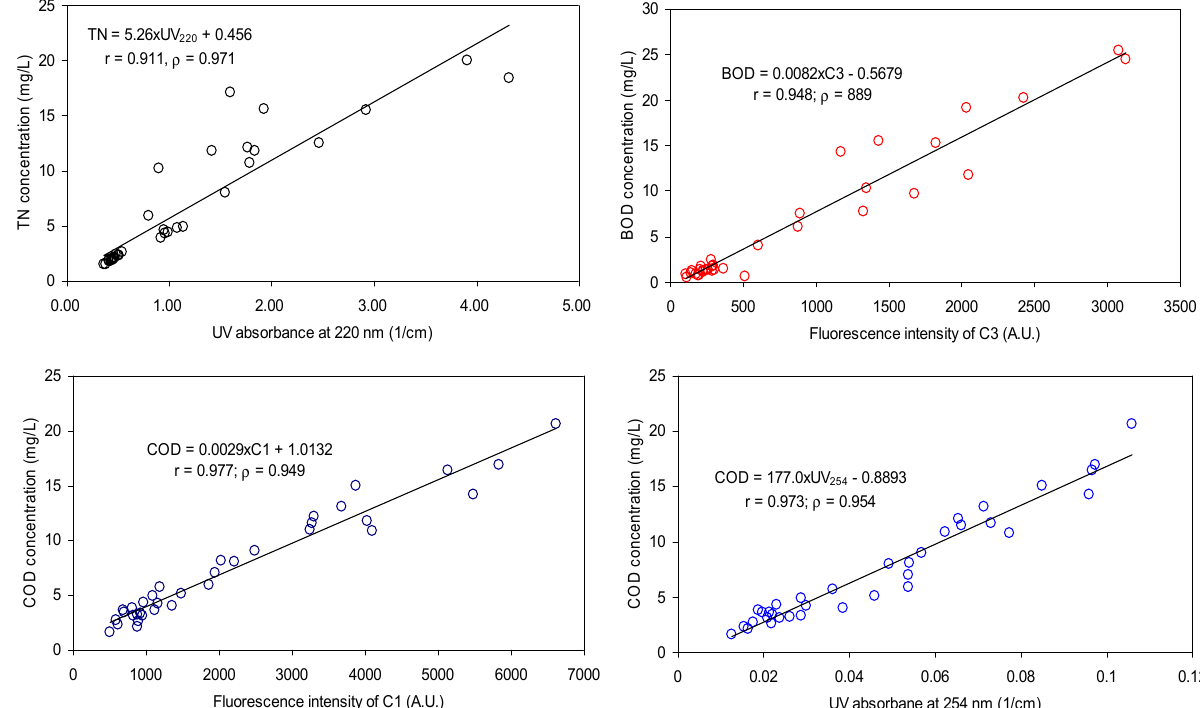
Figure 5. Correlations between selected spectroscopic indices (UV absorption indices or PARAFAC components) and water quality parameters (TN, BOD, and